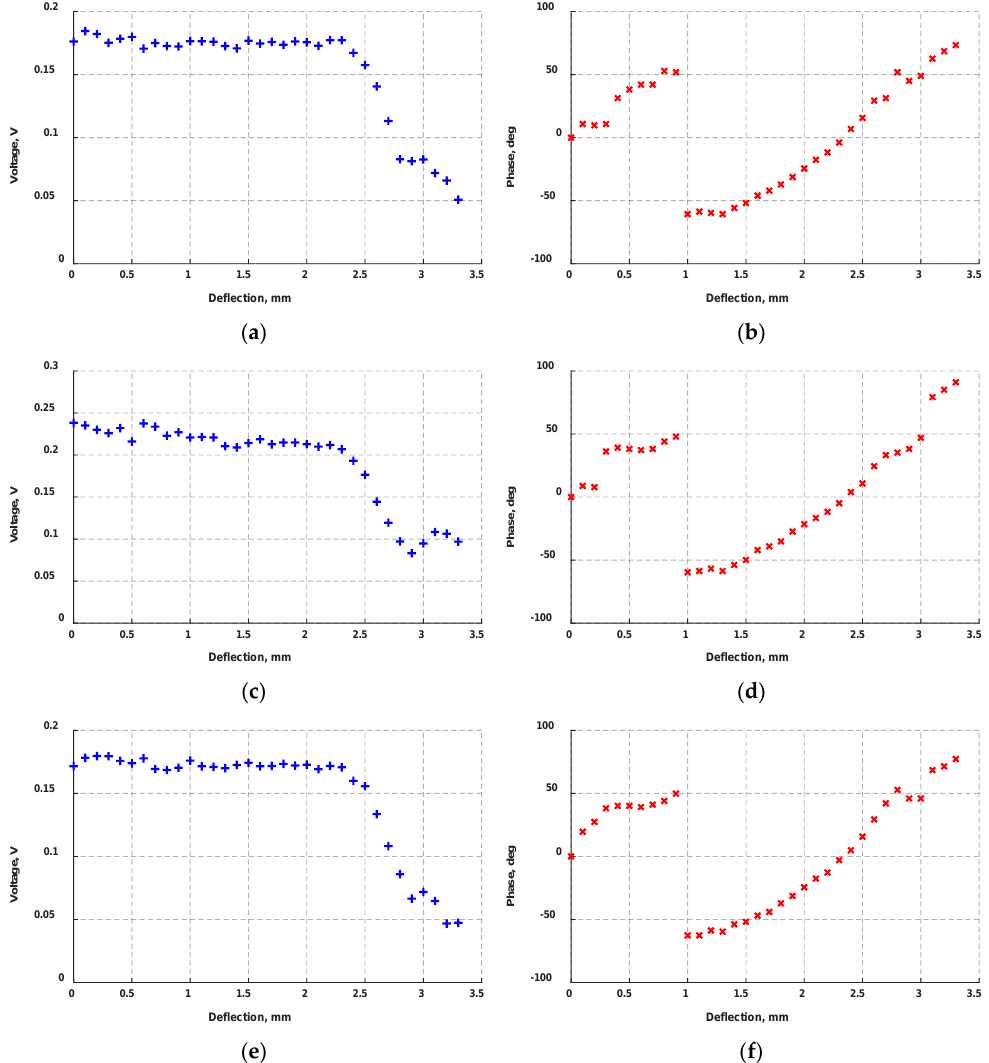
Figure 10. Maximum voltage amplitude (left column) and phase shift (right column) from waveform signals collected from bondline-embedded d15 PZT and surface mounted d31 PZT sensors for wave propagation paths: ( a , b ) PZT-1 → PZT-2; ( c , d ) PZT-1 → PZT-3; and ( e , f ) PZT-2 → PZT-1.